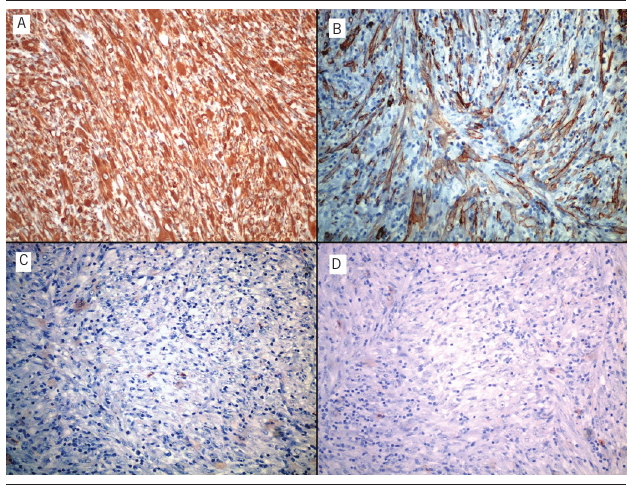
figuRE 2 − Immunohistochemistry results The neoplastic cells showed positive staining for vimentin (A) and smooth muscle actin (B), and negative staining for pan-cytokeratin AE1/AE3 (C) and CD117 (D). All images were captured at 200×